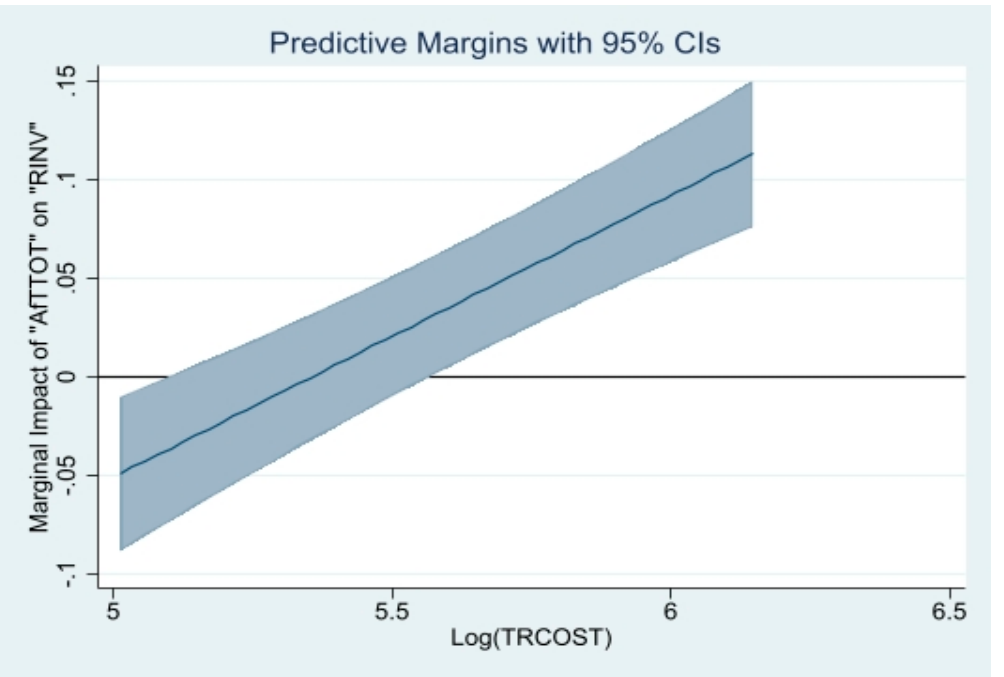
Figure 6. Marginal impact of “AfTTOT” on “RINV” conditioned on the level of the overall trade costs. Source: Author.